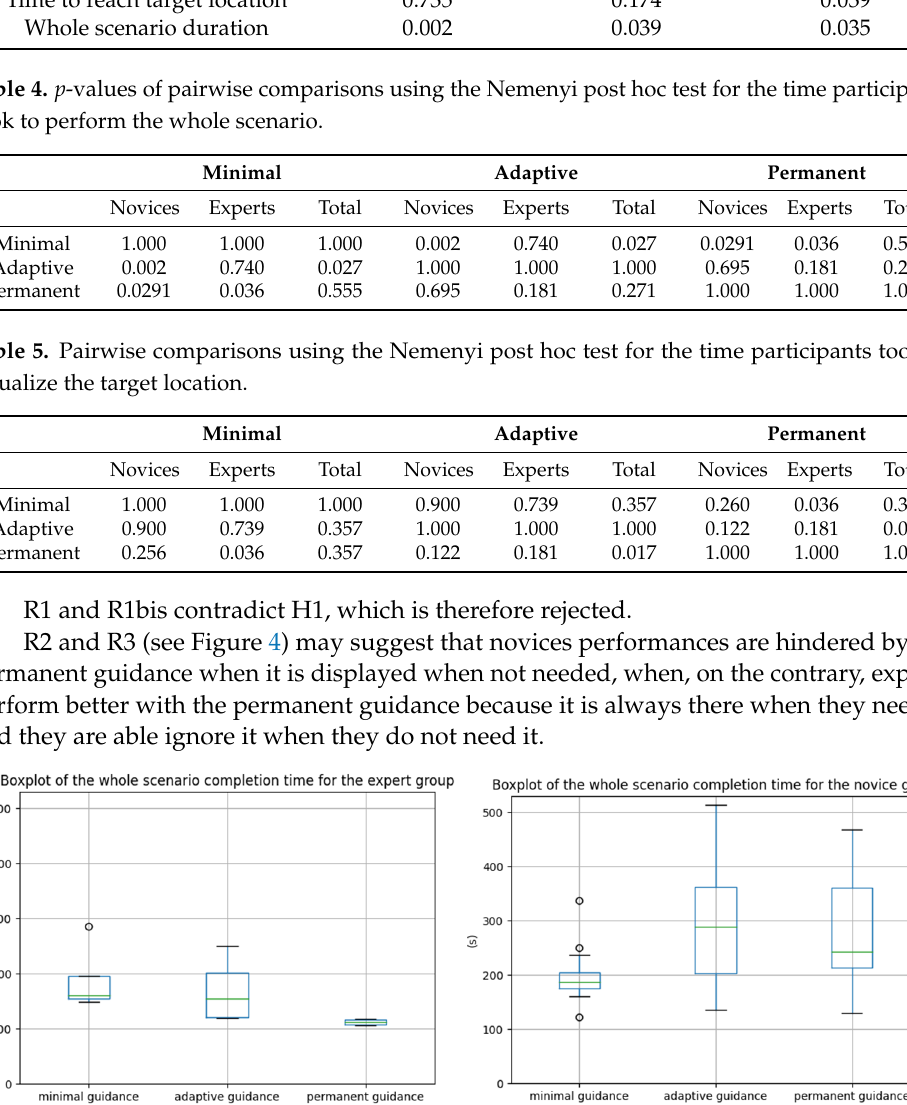
Figure 4. Boxplots of task completion by guidance type. On the left are the boxplots of experts’ task completion time, and on the right are the boxplots of novices’ task completion time. While experts